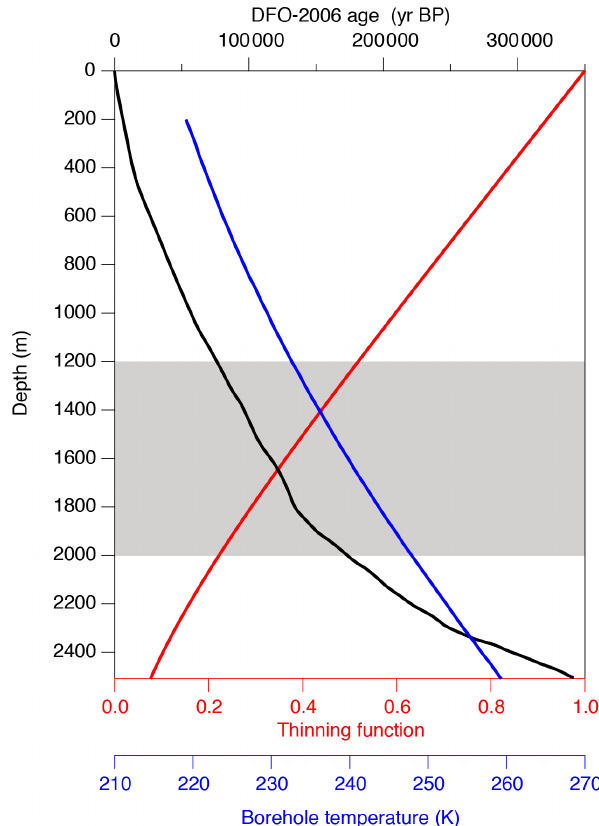
Figure A2. Thinning function (red, Nakano et al., 2016), temper- ature (blue, Buizert et al., 2021) and age (black, Kawamura et al., 2007) in the ice sheet at Dome Fuji used for the diffusion model. Gray shading indicates the depth range of the model